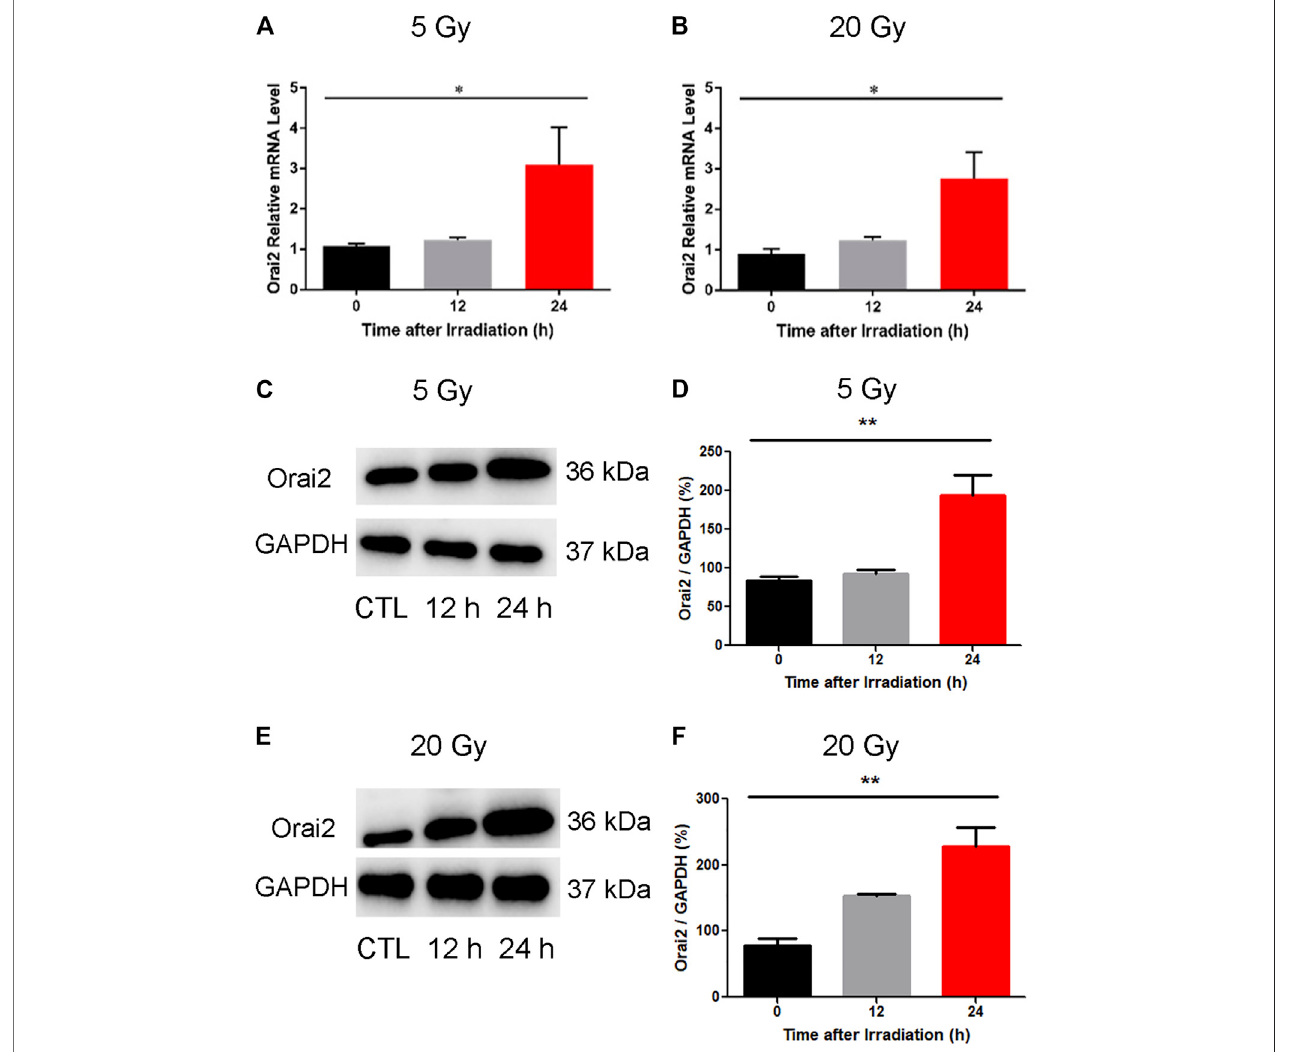
FIGURE 7 | Effect of x-ray exposure on the expression of Orai2 on the mRNA and the protein levels. (A – B) Orai2 mRNA expression levels in irradiated BMECs relativetocontrolsaresigni fi cantlyincreased24 hafter 5 Gy (A) or 20 Gy (B) .Dataareshownasthemean ± SEM( n (cid:2) 3 – 6).* p < 0.05 vs .thecontrolgroup. (C – F) Effect of x-ray exposure on Orai2 expression in brain microvascular endothelial cells. Representative images (C, E) and summary data (D, F) showing Orai2 expression in the cells exposed with 5 Gy or 20 Gy x-ray and continuing cultured for 12 h or 24 h. The control group were not irradiated. GAPDH was loading as a control. Data are shown as the mean ± SEM ( n (cid:2) 4). * p < 0.05, ** p < 0.01 vs . the control